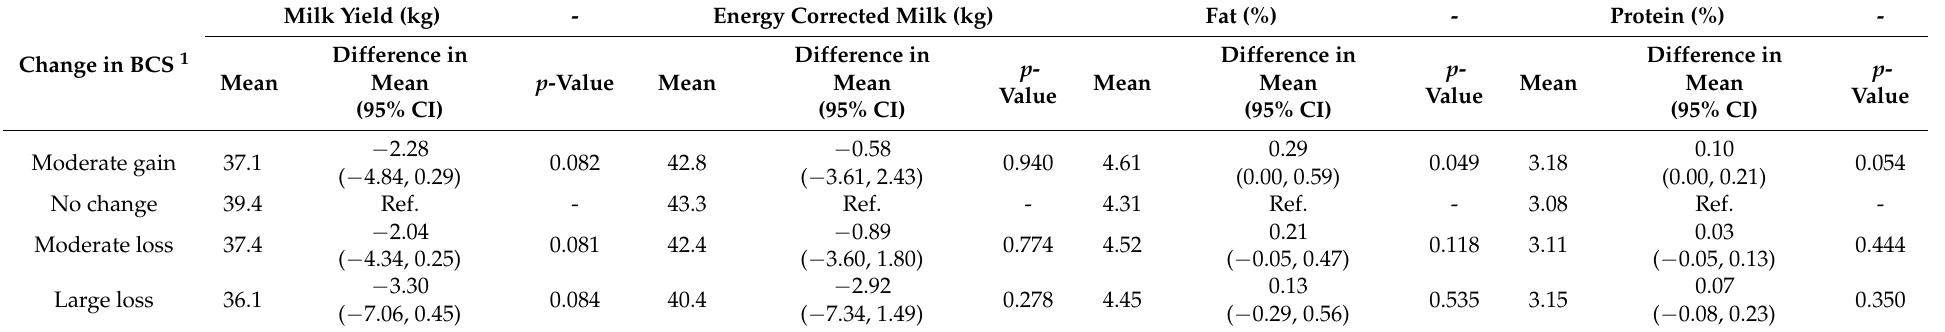
Table 4. Variations in milk yield and composition (marginal means and mean differences) at the first monthly milk test day according to BCS-change during the close-up period (d − 21 to d 0). Milk Yield (kg) - Energy Corrected Milk (kg) Fat (%) - Protein (%) - Change in BCS 1